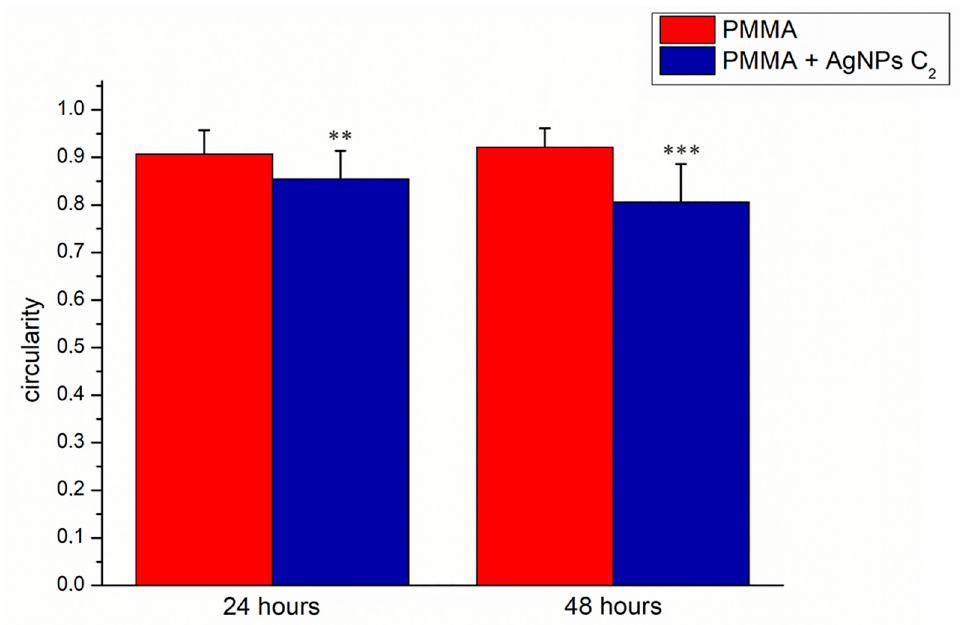
Figure 7. Histogram reported the mean values and their respective standard deviation of C. albicans